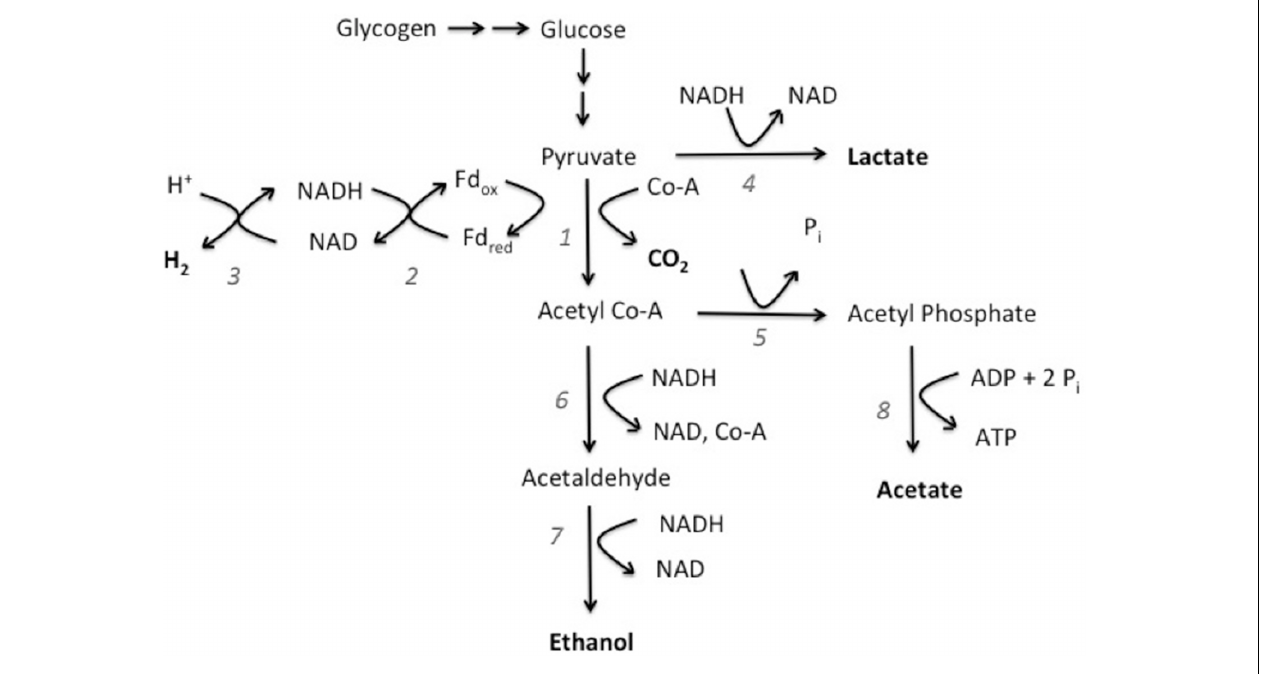
FIGURE 3 | Proposed fermentation pathway of glycogen (polyglucose) fermentation in L. aestuarii BL J. Compounds in bold are fermentation products. The numbers refer to the enzymes involved: 1, pyruvate ferredoxin